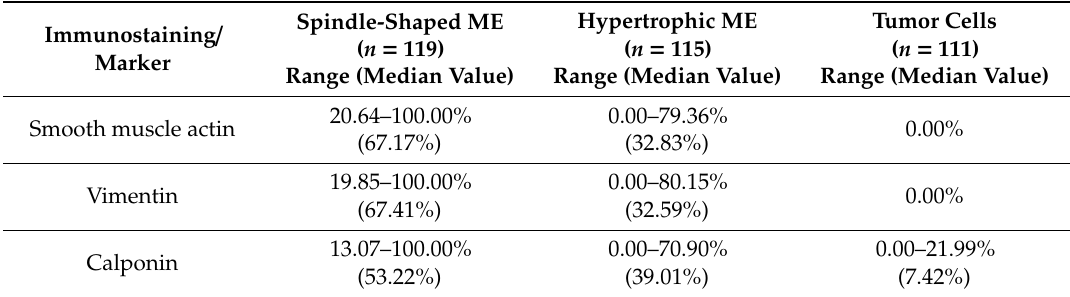
Table 4. Percentages of Non-Neoplastic Myoepithelial Cells and Tumor Cells Expressing